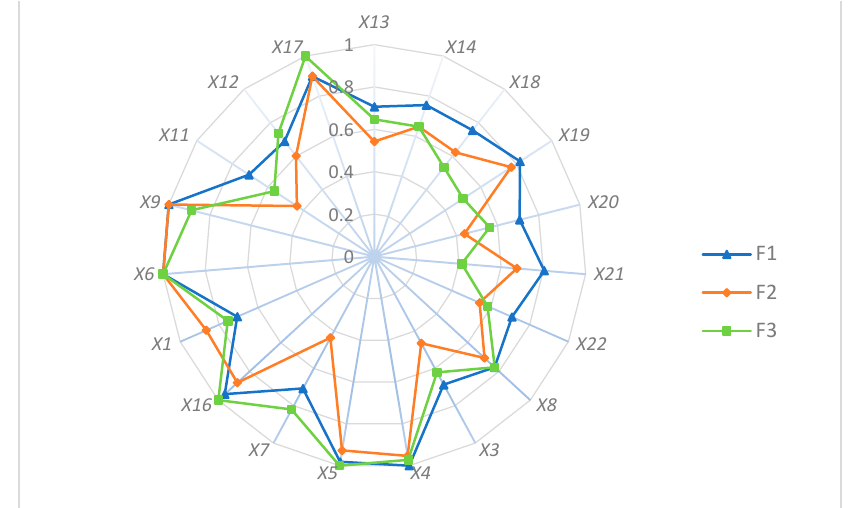
Figure 12. Criteria performances of each design solution.